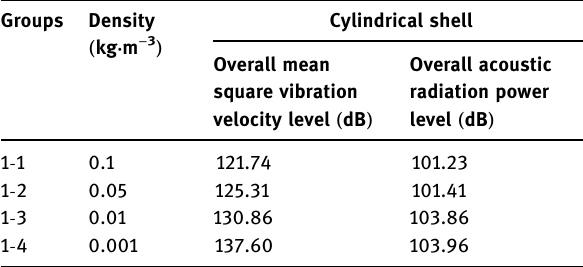
Table 1: Total level of vibration and radiation power of shell under di ff erent density materials Groups Density ( kg · m − 3 )